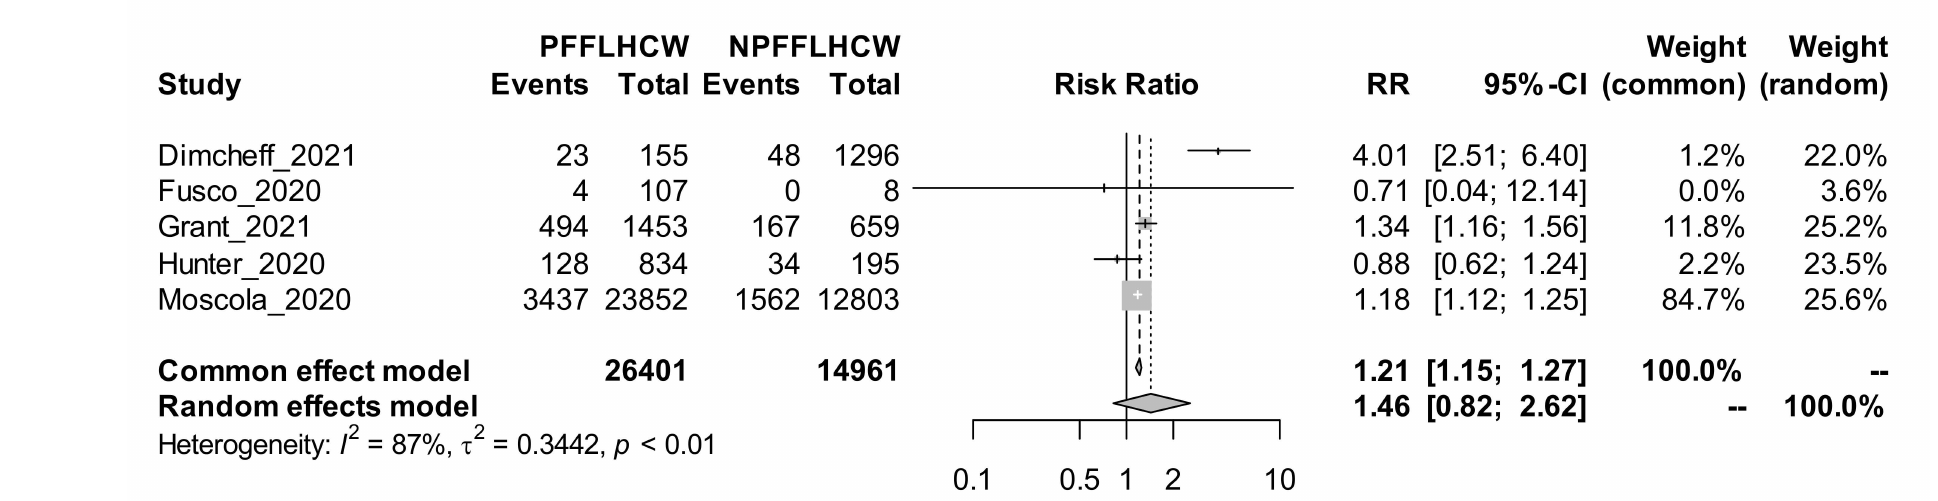
Figure 5. Forest plot showing the risk of COVID-19 between patient and non-patient facing